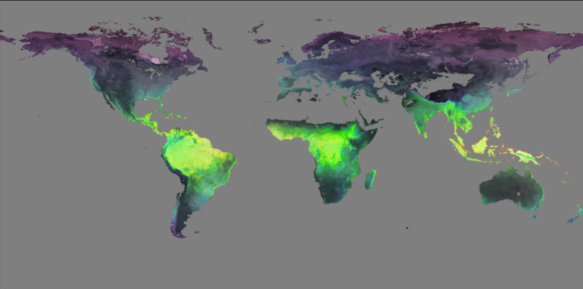
Figure 1. Map of the first three leading principal components (PCs) colored according to the color space hue (PC1), saturation (PC2), and lightness (PC3). Coloring according to hue (i.e., the color wheel specifies the tone of the color), saturation (intensity of the color ranging from grey to pure color), and lightness (brightness of the color, ranging from black to white) is one way to get an impression of three-dimensional data on a